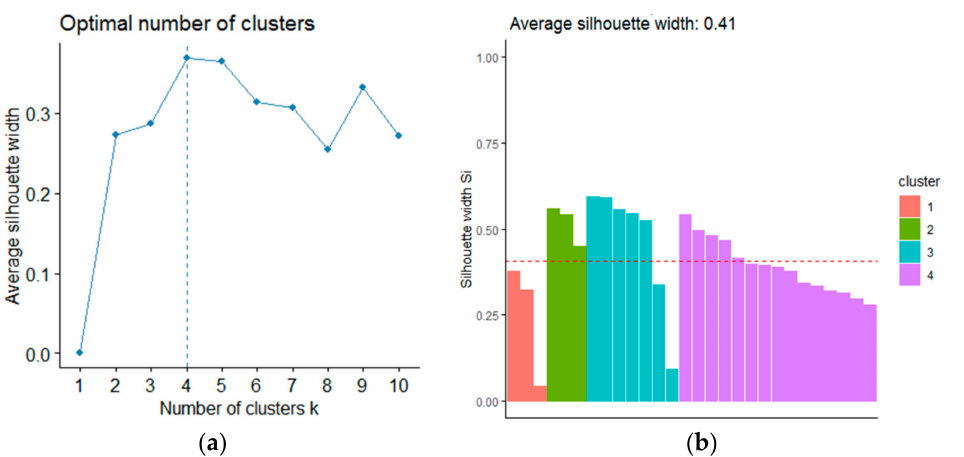
Figure 11. ( a ) The average silhouette index for different numbers of clusters, ( b )value of silhouette index for each country in k-means clustering.